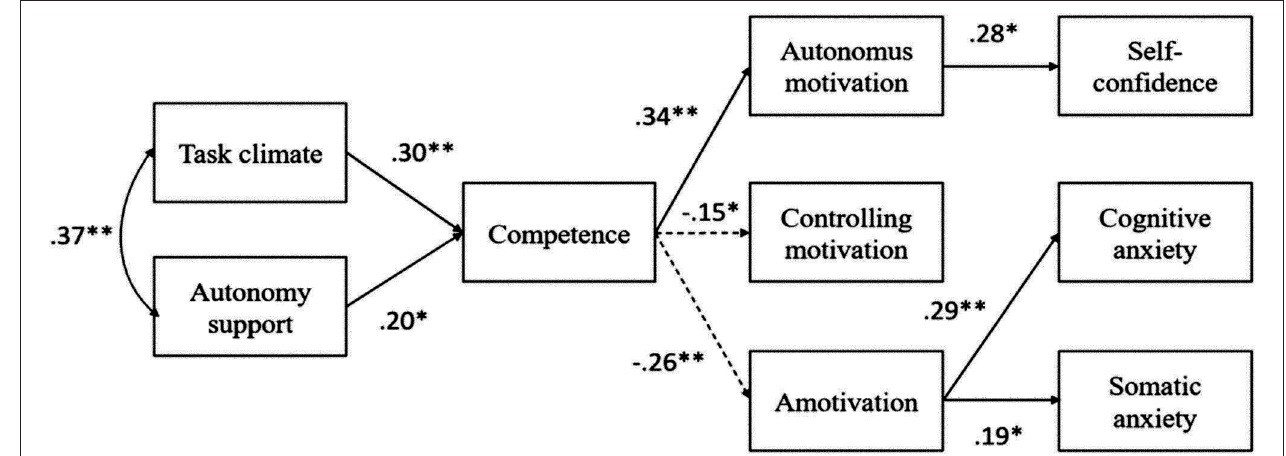
FIGURE 2 | Standardized solution of the hypothesized structural model of mediation. * p < 0.05; ** p < 0.01.